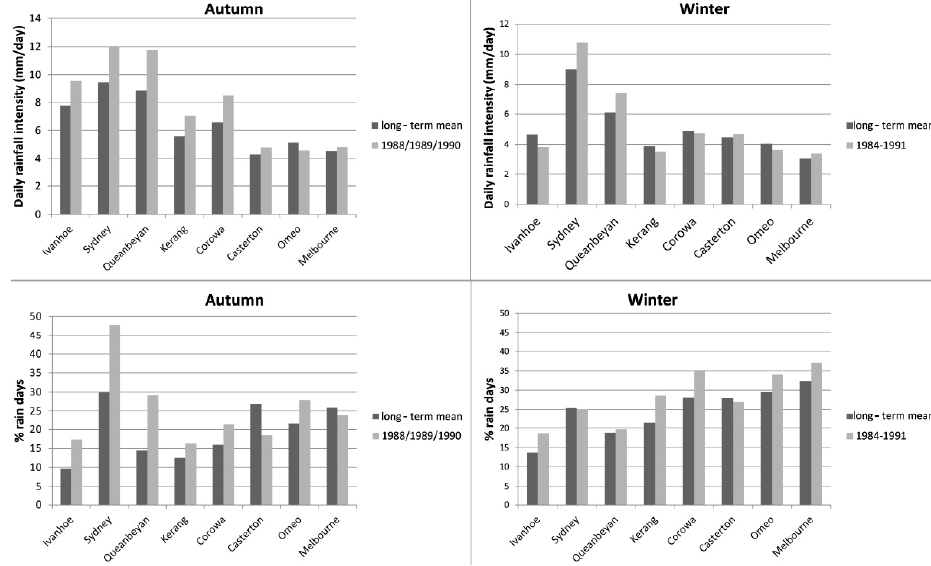
Figure 7. Daily rainfall intensity and percentage of rain days for the eight selected high-quality rainfall stations in SEA during wet years compared to long-term mean